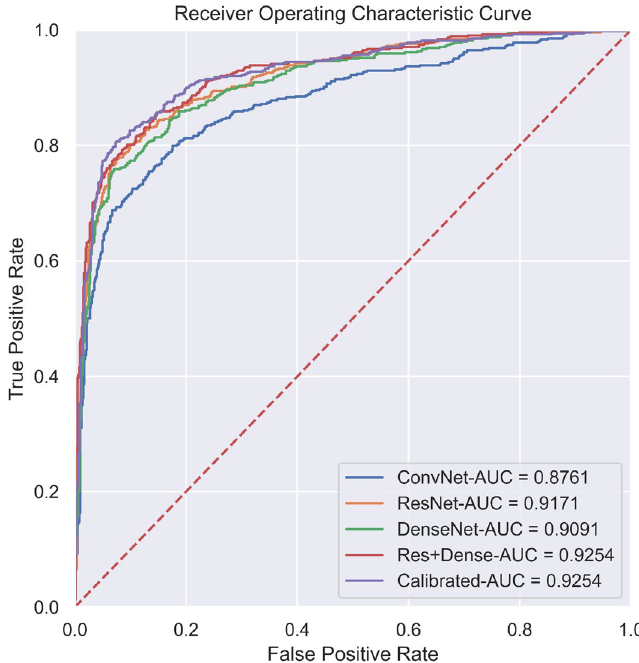
Figure 2. ROC curves of five